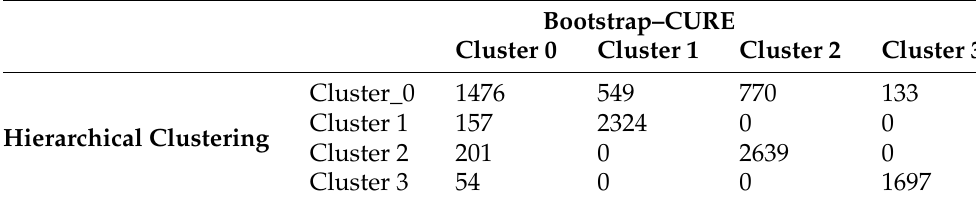
Table 3. Cluster evaluation between hierarchical and